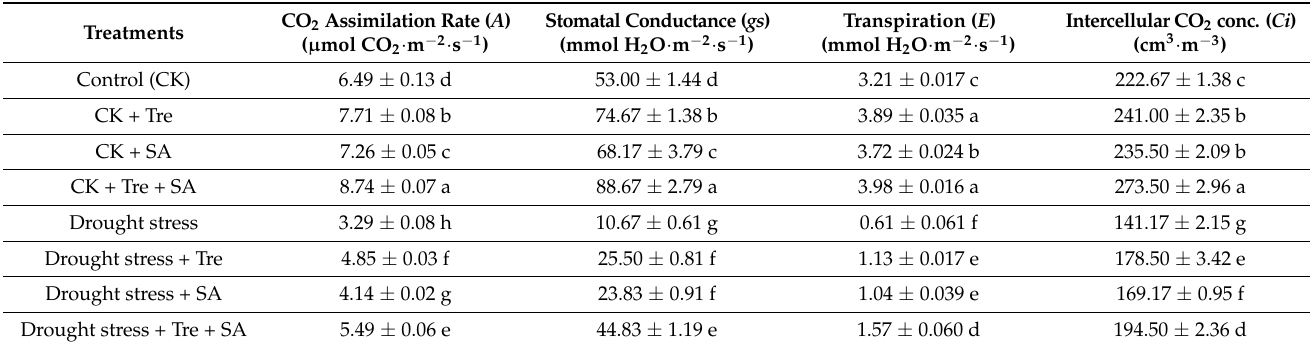
Table 2. Effect of foliar application of 30 mM trehalose (Tre) and/or 1 mM salicylic acid (SA) on leaf gas exchange traits in sweet basil seedlings grown under well-watered (control, CK) and drought stress conditions. Values are the means ± SE ( n = 6). Different letters within a column indicate significant differences among means according to Duncan’s multiple-range test at the p < 0.05 level.